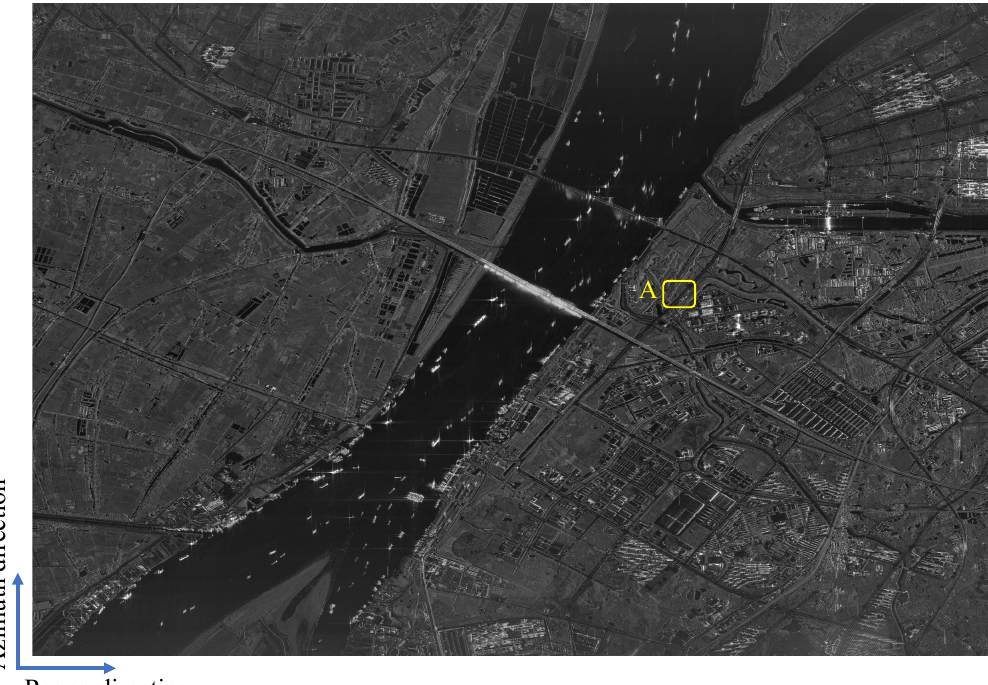
Figure 12. The imaging result of GF-3 spotlight data.